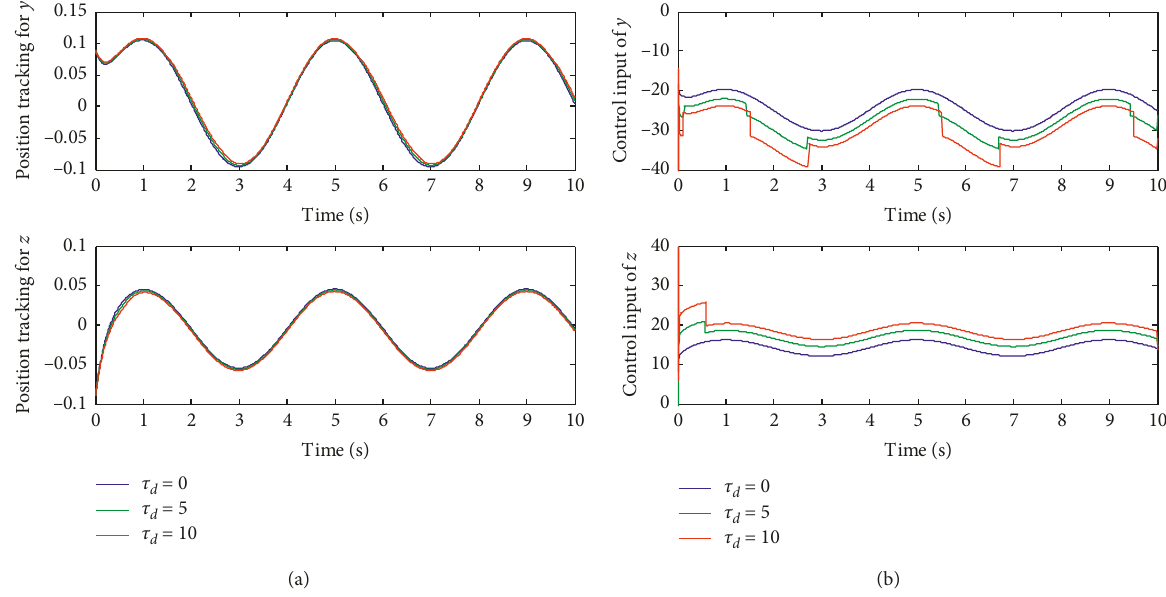
Figure 5: The displacements of flap(z)/lead-lag(y) motions and the signals of control inputs, under conditions of τ